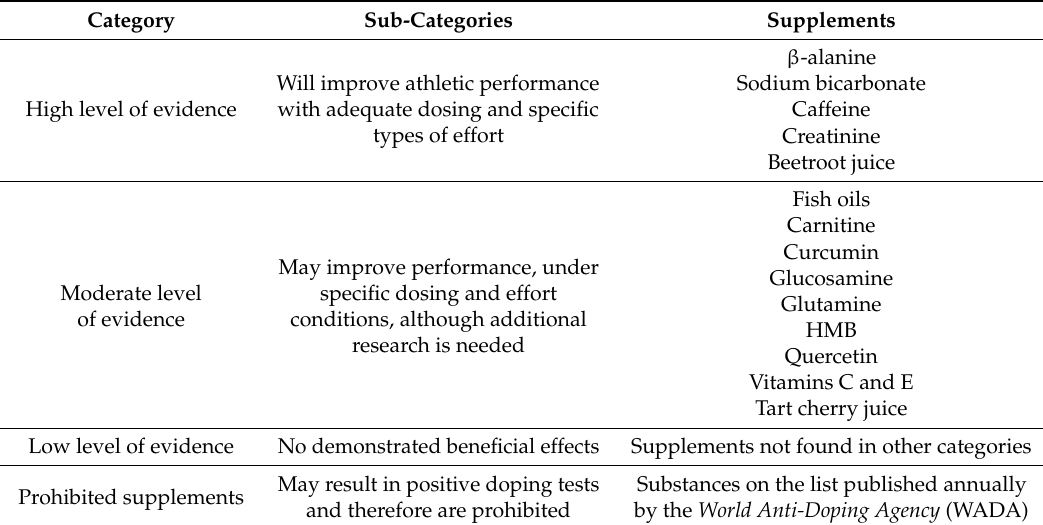
Table 1. Classification of nutritional supplements, based on performance effect. Adapted from Australian Institute of Sport [9] and Burke